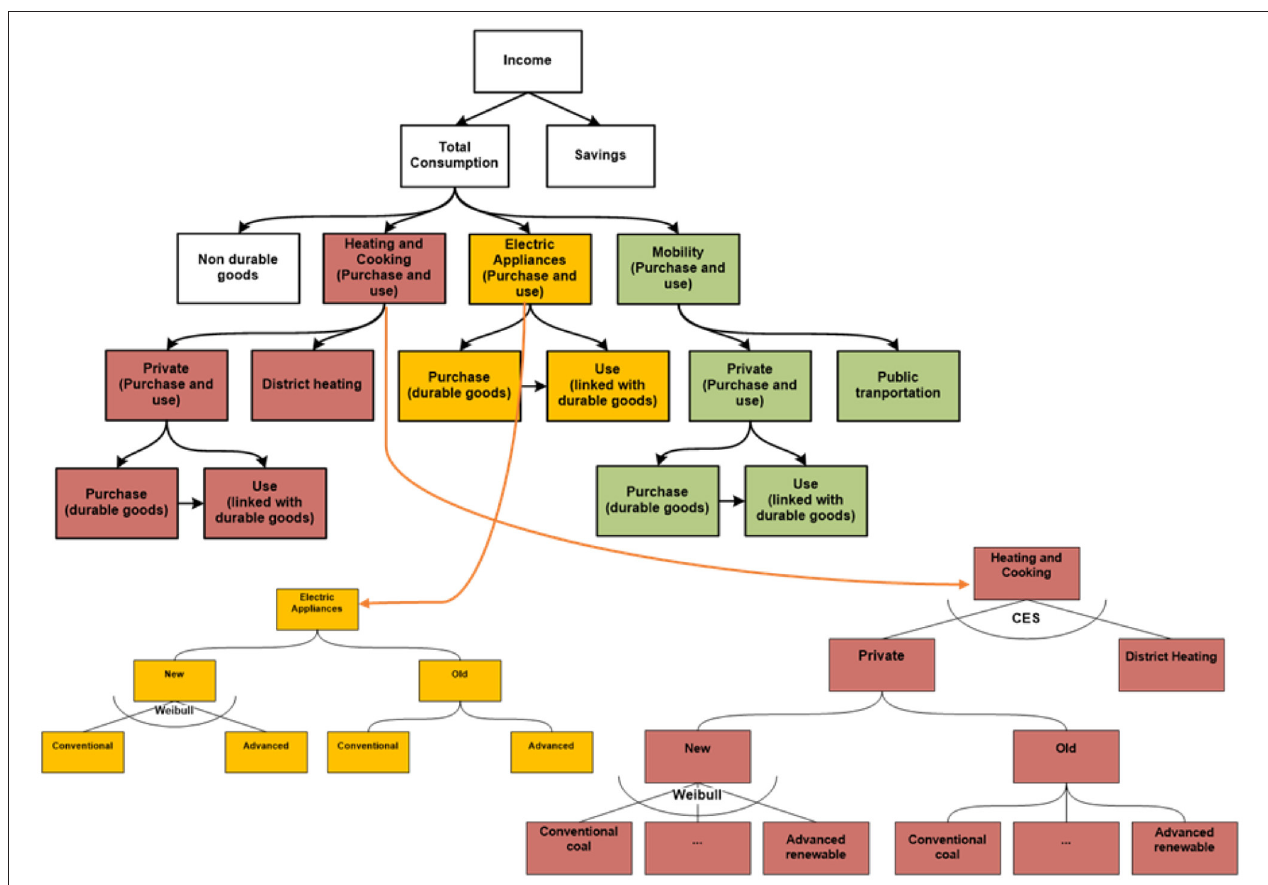
FIGURE 2 | Decision tree of households, including energy and mobility